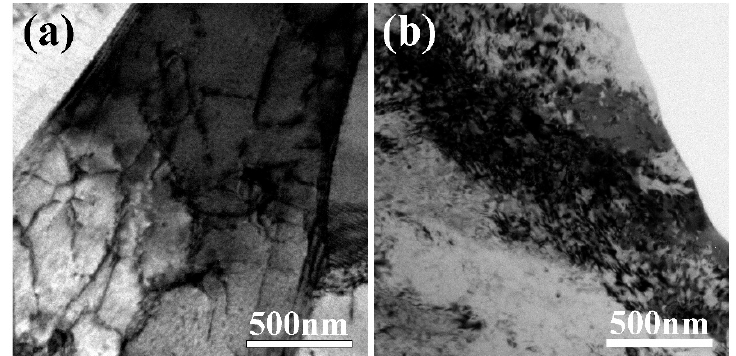
Figure 3. The morphology of dislocations in the T6-treated sample ( a ) or AR sample ( b ).